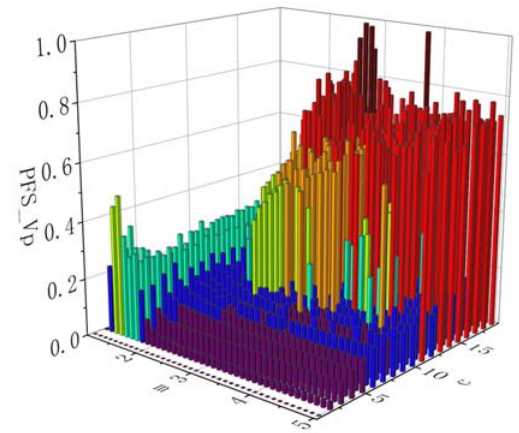
Figure 7. PFS_Vp value under different values of c and m .